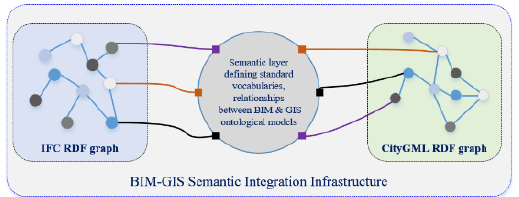
Figure 8. BIM-GIS integration infrastructure (ontological model)